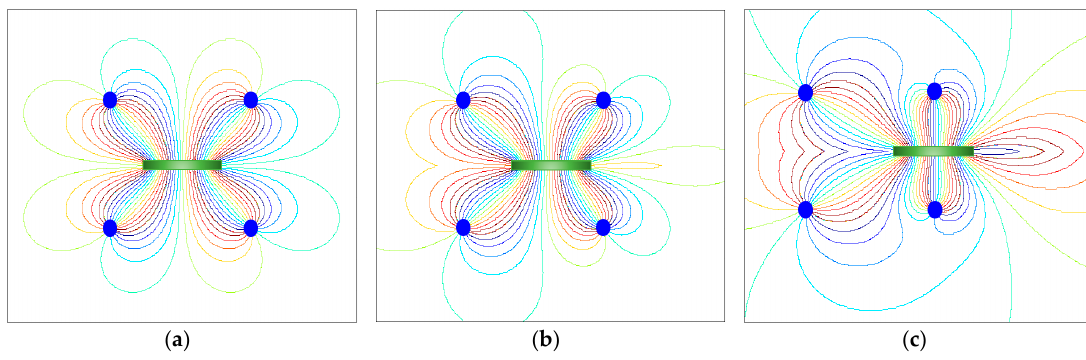
Figure 13. Stream line pattern for lateral shifting of the horizontal well. (( a – c ) show the stream line pattern of different lateral location.)